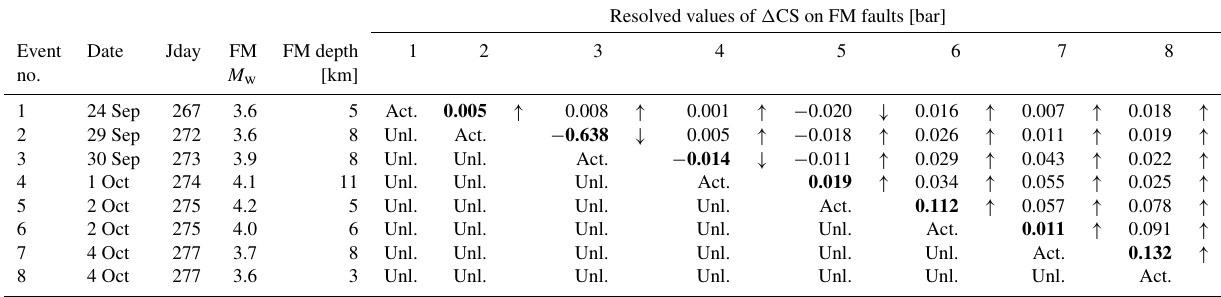
Table 3. Cumulative (cid:49) CS evolution on each FM fault. After fault activation on a particular date (act.), it is indicated as unloaded (unl.), and no numeric value is provided. The arrows next to each value indicate whether the fault plane experiences an increase or decrease in Coulomb stress with respect to its previous state. At the beginning of the series, we suppose CS = 0. Values are inbar units. Resolved values of (cid:49) CS on FM faults